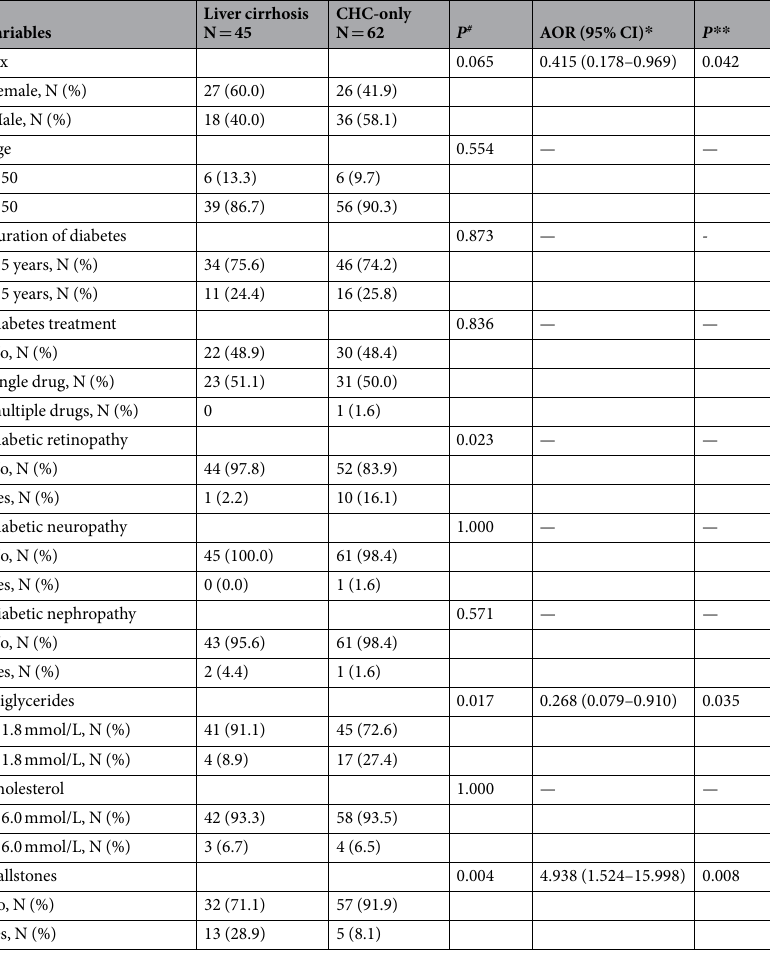
Table 3. Association between the risk of liver cirrhosis development and diabetes duration, diabetes treatment, diabetes complications, and other variables in diabetes patients. CHC = chronic hepatitis C; AOR = adjusted odds ratio; CI = confidence interval. Continuous variables are expressed as median (25th, 75th percentiles). # P value for univariate analysis. * Adjusted for sex, age, duration of diabetes, diabetes treatment, diabetic retinopathy, diabetic neuropathy, diabetic nephropathy, triglycerides, cholesterol, gallstones, and liver